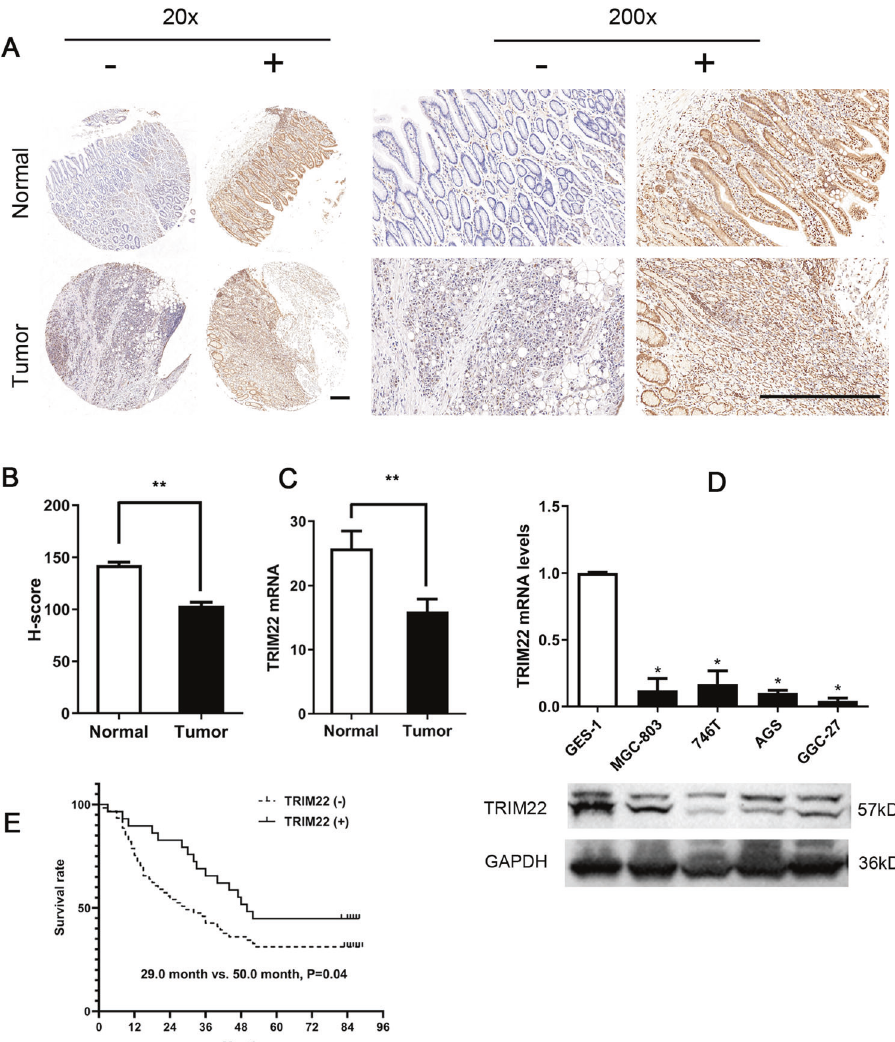
Fig. 1 TRIM22 expression is downregulated in gastric cancer tissues and cells. A Immunohistochemical staining image of TRIM22 in gastric cancer and adjacent tissues (magni fi cation: ×20 and ×200, scale bars = 200 μ m). B H-score of TRIM22 in gastric cancer and adjacent tissues ( n = 90, ** P < 0.01). C Expression of TRIM22 mRNA (qPCR, ** P < 0.01). D Expression of TRIM22 mRNA and protein in gastric cancer cell lines (qPCR and WB, * P < 0.01). E Kaplan – Meier survival curve analysis of TRIM22 in gastric cancer. Data are shown as mean ± SD of three independent